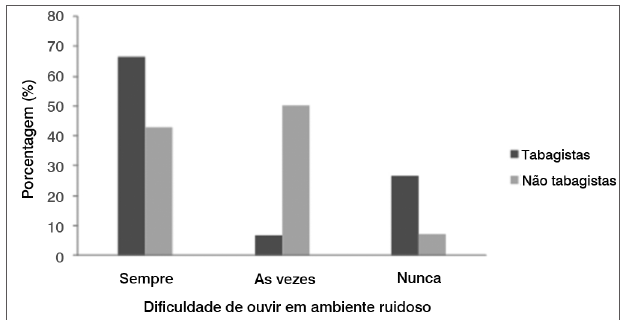
Figura 3. Queixa de dificuldade de ouvir em ambientes ruidosos em indivíduos do gênero feminino, adultos jovens, normo-ouvintes, taba- gistas e não tabagistas